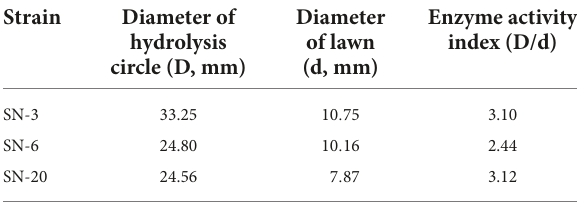
TABLE 1 Enzyme activity (EA) index of SN-3, SN-6, and SN-20. Strain Diameter of